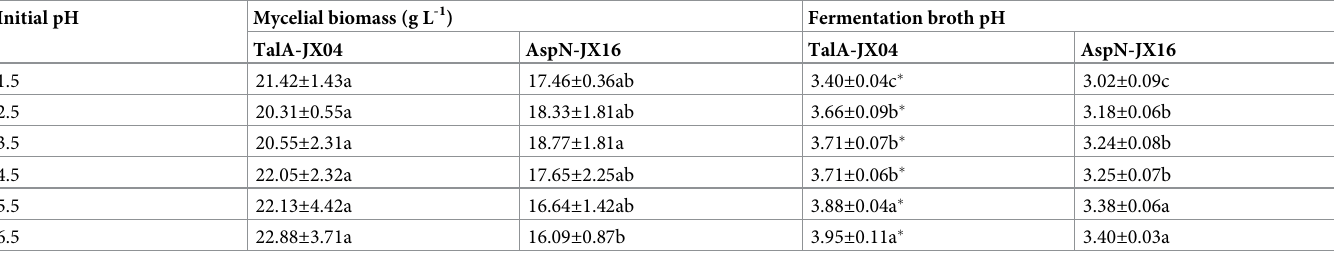
Note: Value = Mean ± standard error. Different letters indicated significant differences ( p < 0.05) among the pH in the same strain. The asterisk ( (cid:3) ) indicated the significant difference ( p < 0.05) between TalA-JX04 and AspN-JX16 with the same